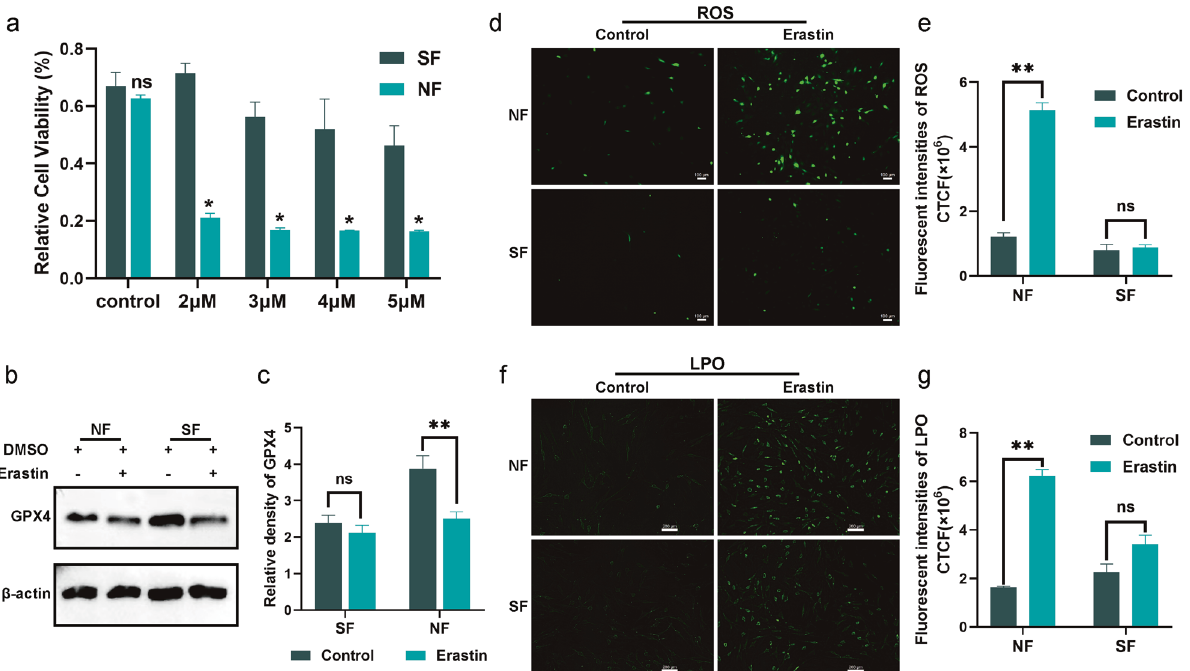
Fig. 2 Senescent fi broblasts exhibit a ferroptosis-resistant phenotype. a Relative cell viability of erastin (2, 3, 4, 5 μΜ ) -stimulated fi broblasts. b Protein level of GPX4 after 5 μΜ erastin treatment. c Quanti fi cation of GPX4 immunoblotting in b . d , f Intracellular ROS and LPO level in fi broblasts with the indicated treatment. Scale bar in d = 200 μ m, Scale bar in f = 100 μ m. e , g Quanti fi cation of ROS and LPO level in d and f . Data represent the mean ± SEM of triplicates. * P < 0.05; ** P < 0.01; ns nonsigni fi cant, NF normal fi broblast, SF senescent fi broblast, CTCF corrected total cell fl